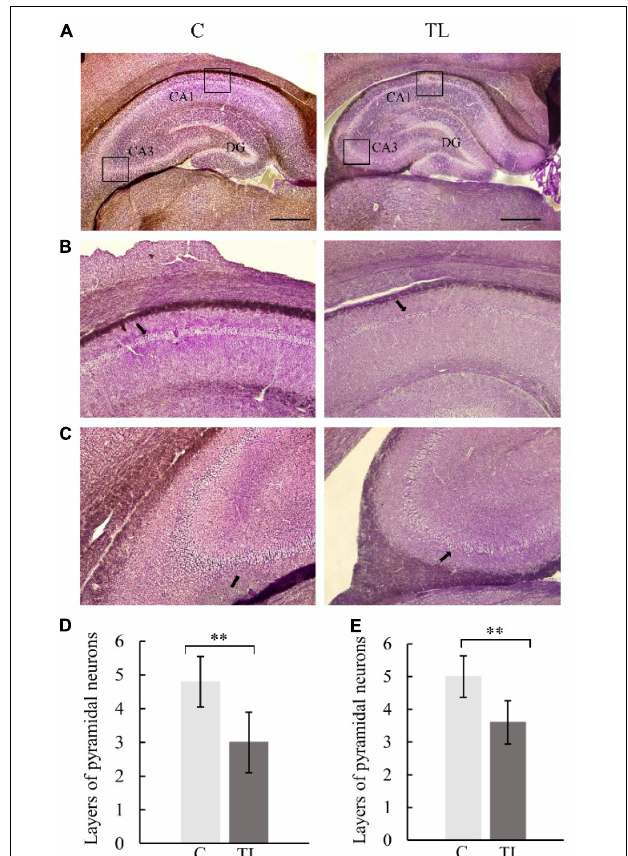
FIGURE 3 | Optical micrograph of rat hippocampus. (A) The morphology of hippocampus in the C group and TL group was similar, with a scale of 1 mm. (B) Vertebral cell layer in CA1 region of the C and TL groups, with black arrow identifying the pyramidal cells. (C) Vertebral cell layer in the CA3 region of the C and TL groups, with black arrow identifying the pyramidal cells. (D) The layers number of pyramidal neurons in CA1 region in two groups. The data are expressed as the mean ± SD, **indicates that there is a statistical difference between the two groups ( t -test, ** P < 0.01). (E) The layers number of pyramidal neurons in CA3 region in two groups. The data are expressed as the mean ± SD, ∗∗ indicates that there is a statistical difference between the two groups ( t -test, ∗∗ P <